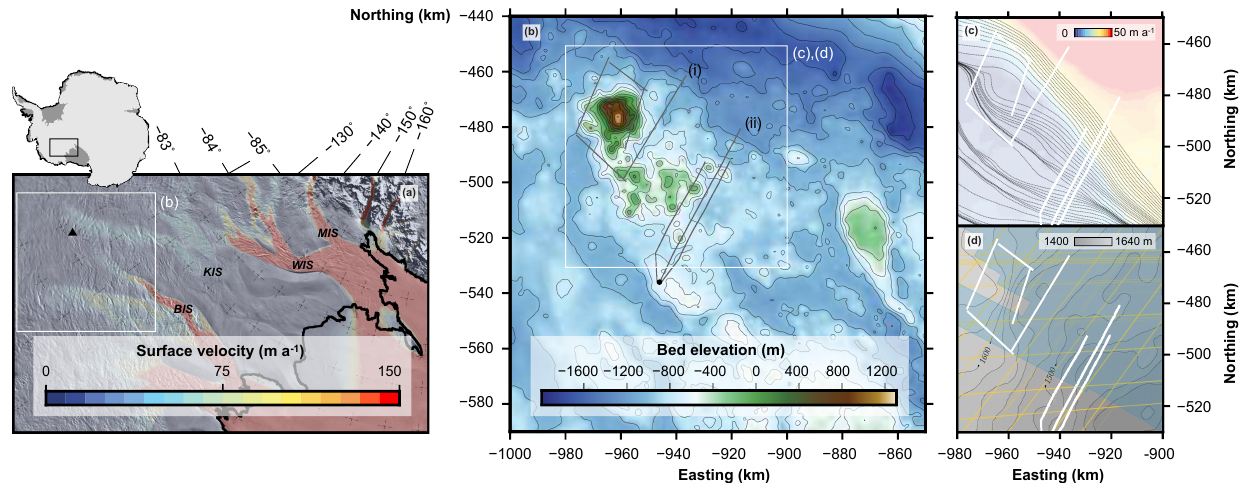
Figure 1. (a) Region map showing the modern flow field (Joughin and Tulaczyk, 2002) of Bindschadler (BIS), Kamb (KIS), Whillans (WIS), and Mercer (MIS) ice streams. Mt. Resnik, a subglacial volcanic complex (plotted as a black triangle), sits adjacent to a tributary of the stagnating Kamb Ice Stream, near the catchment divide between Kamb and Bindschadler ice streams. (b) Map of the subglacial topography at Mt. Resnik (Morse et al., 2002). Two ground-based radar surveys are plotted in black: (i) 1MHz data collected by the University of Washington in 2004 and (ii) 3MHz data collected by St. Olaf College in 2002. (c) Map of modern flow speeds and flow pathways over Mt. Resnik (dashed lines) (Joughin and Tulaczyk, 2002), indicating a dominant flow direction orthogonal to the primary radar survey orientation. (d) Contoured (20m) surface elevation (Helm et al., 2014), plotted with the coverage region for high-resolution DEMs produced as part of this study (blue) calibrated using ICESat altimetry (ground tracks in orange, data version 34, GLAH12).